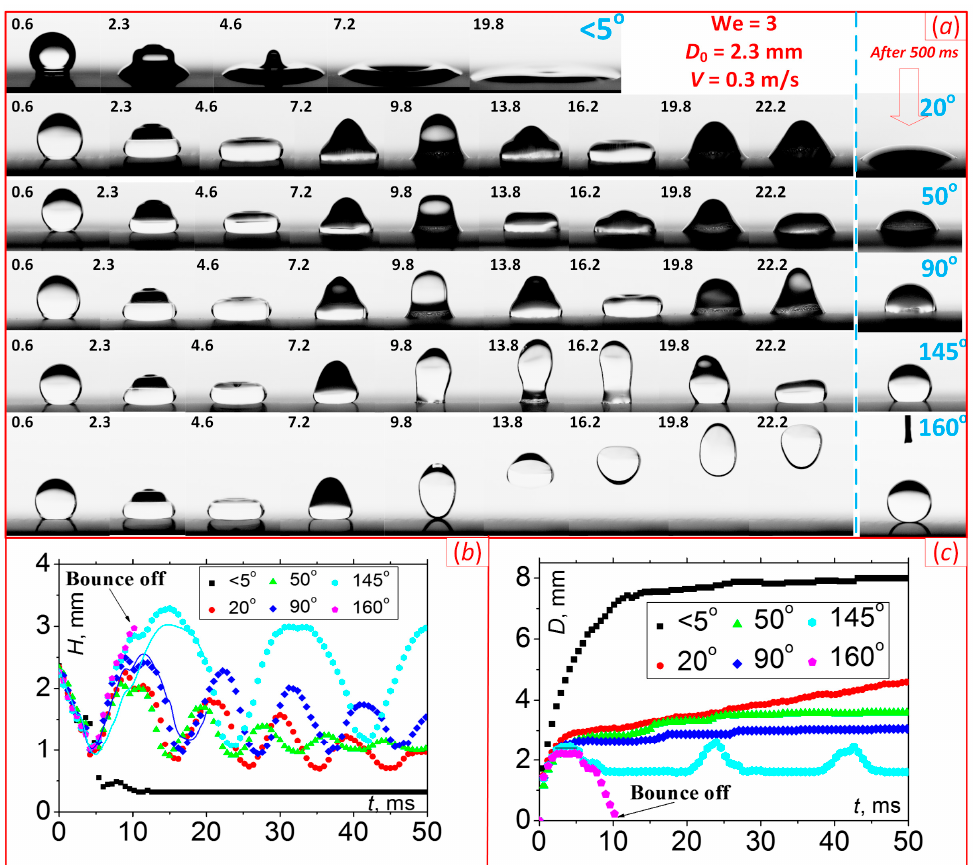
Figure 3. ( a ) Snapshots of droplet D 0 = 2.3 mm falling on surface with different contact angles for We = 3, numbers are time in ms; the dotted line separates the snapshots after 500 ms ( b ) Variation in droplet height and ( c ) contact line diameter with time. Contact angle θ < 5° ( ■ ), 20° ( ● ), 50° ( ▲ ), 90° ( ), 145° ( ), 155° ( ). Solid lines in ( b ) are LBM modeling for surface 4 and 5.